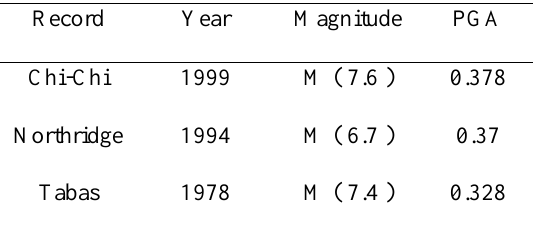
Fig. 9. Generalized force-deformation relation for steel elements (Federal Emergency Management Agency, 1997). Table. 4. Ground motion